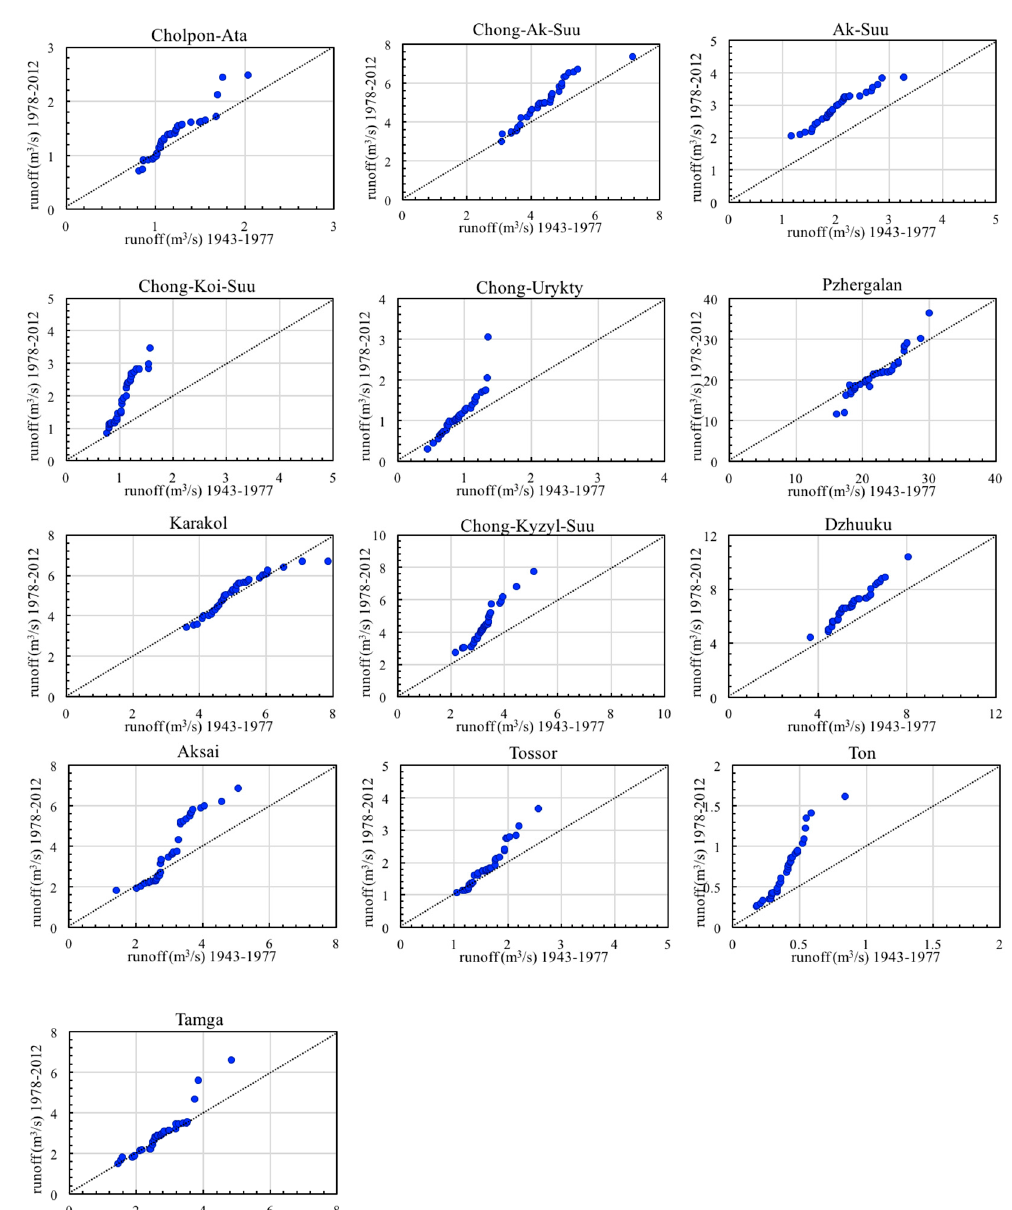
Figure 6. Analysis of the ITA for autumn river runoff at 13 .